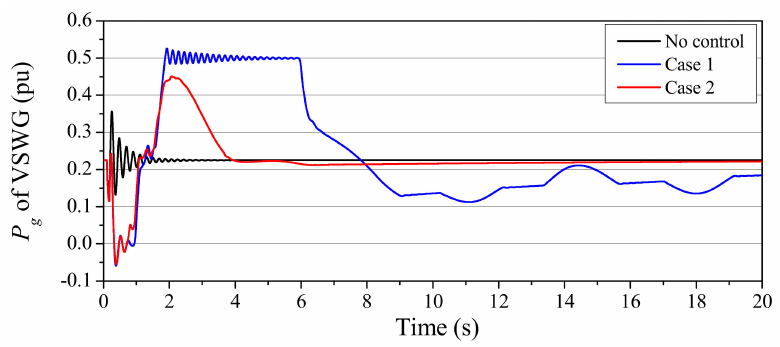
Figure 12. Active power of the VSWG (with SG3 installed).